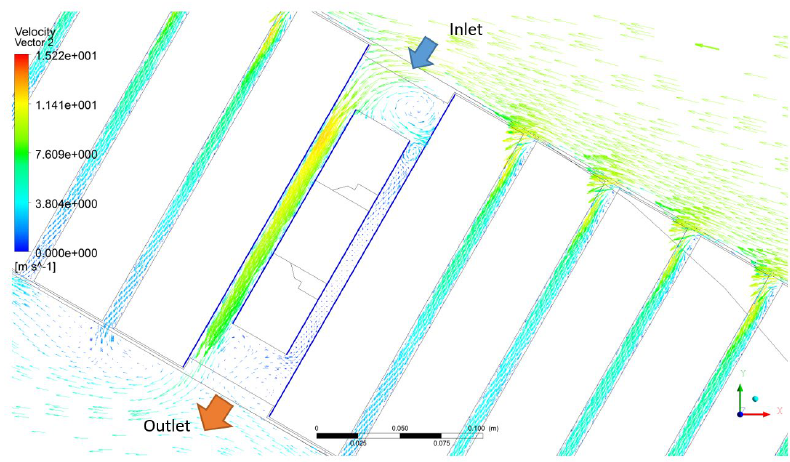
Figure 24. Difference of pressure between A4-A3.